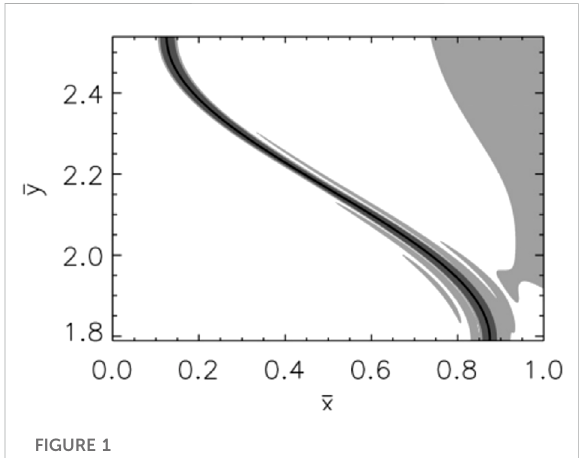
FIGURE 1 Fourth panel from Figure 3 of Russell and Wright